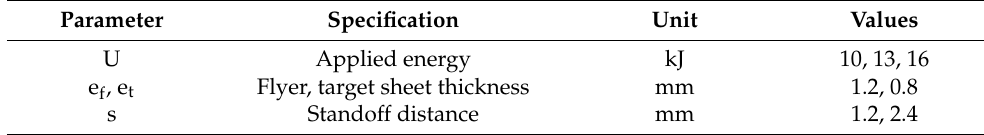
Table A2. Process